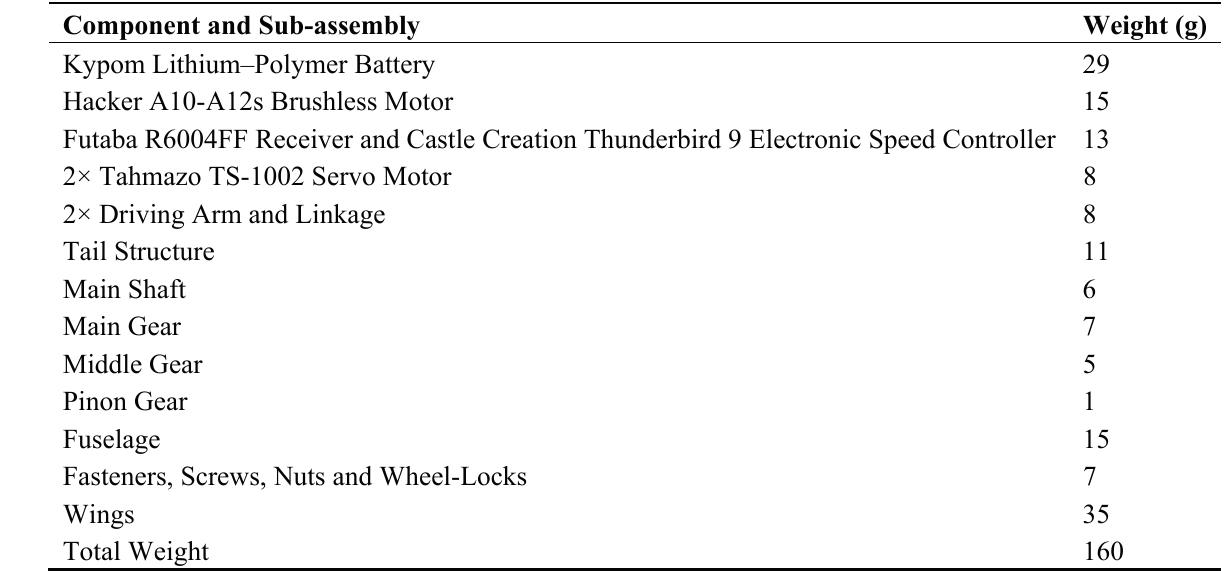
Table 1. Weight of each Component and